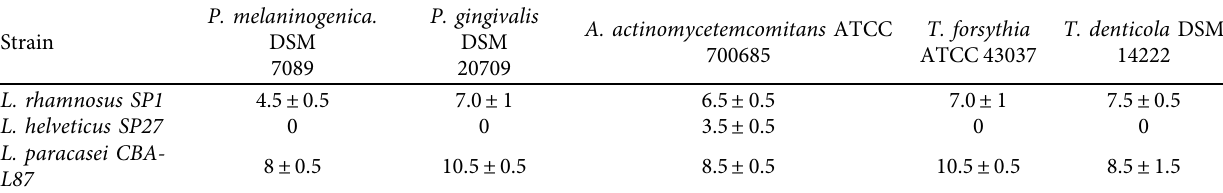
Table 7: Results of inhibition zone measures for each pathogen against the three Lactobacillus strains selected for lipogel preparations. Strain